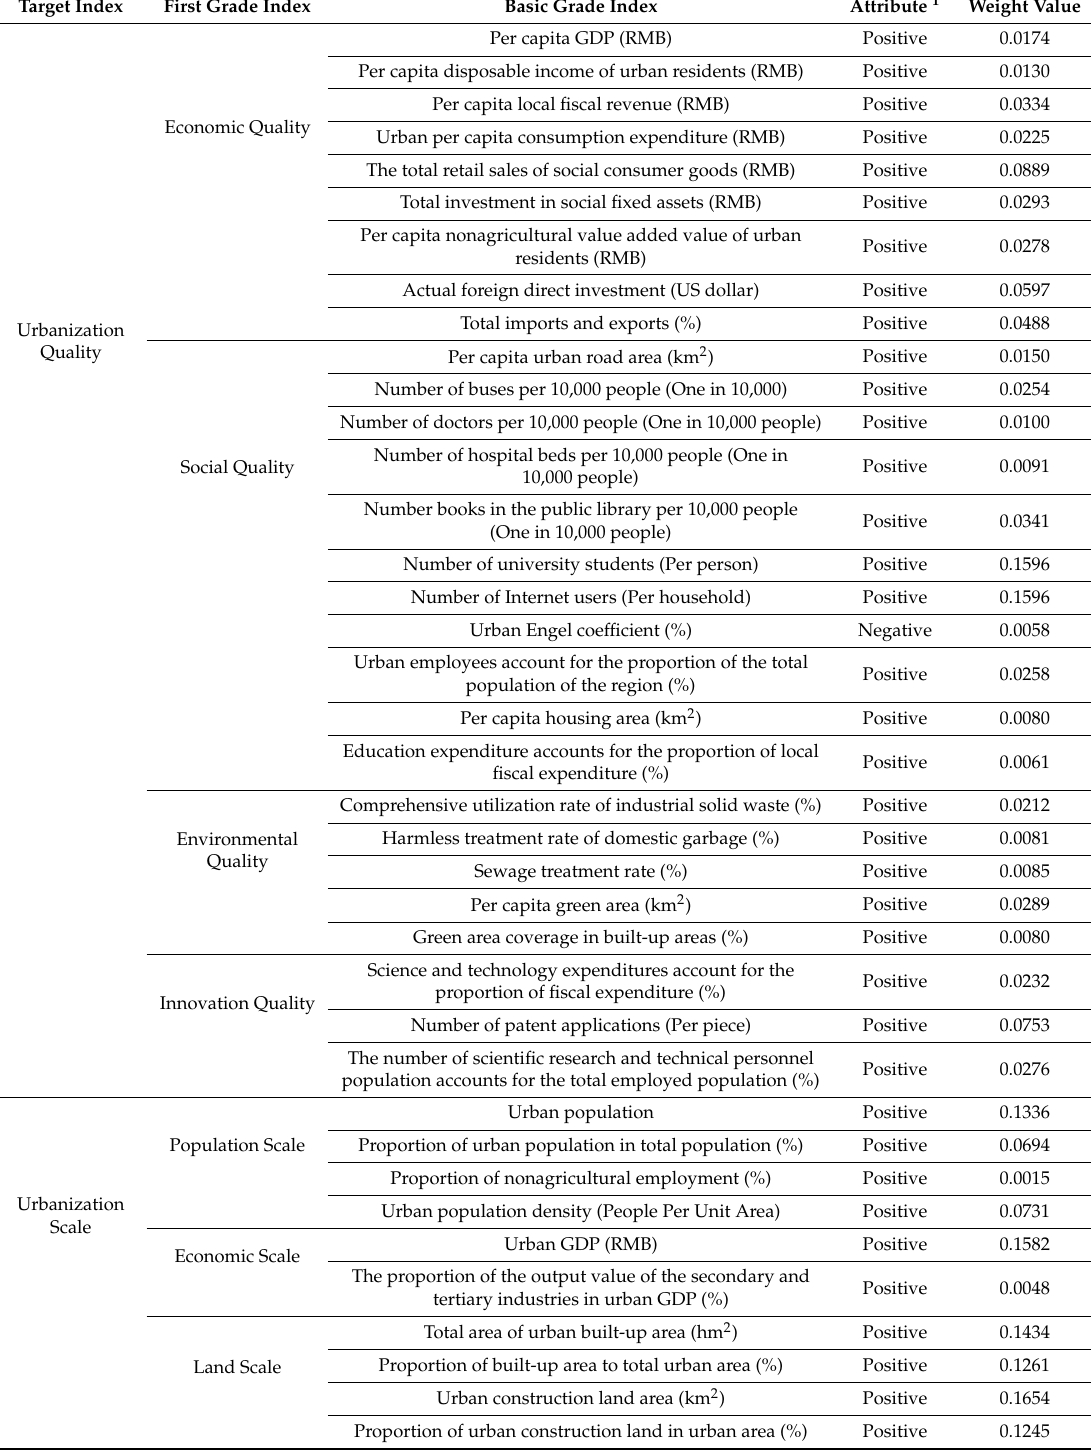
Table 1. Index system of coordination level between urbanization quality and urbanization